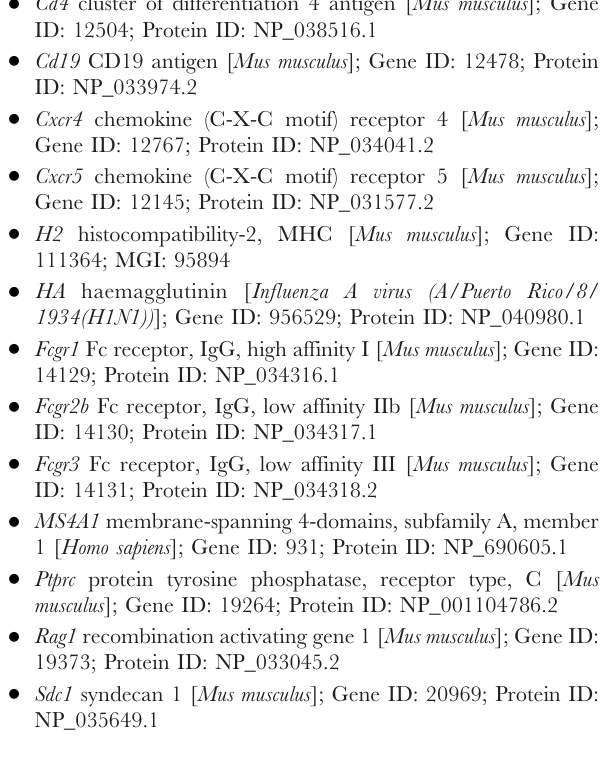
Figure S1 Determination of cross-reactive antibodies to PR8 and P. chabaudi . Graphs in A and B plot the mean O.D.